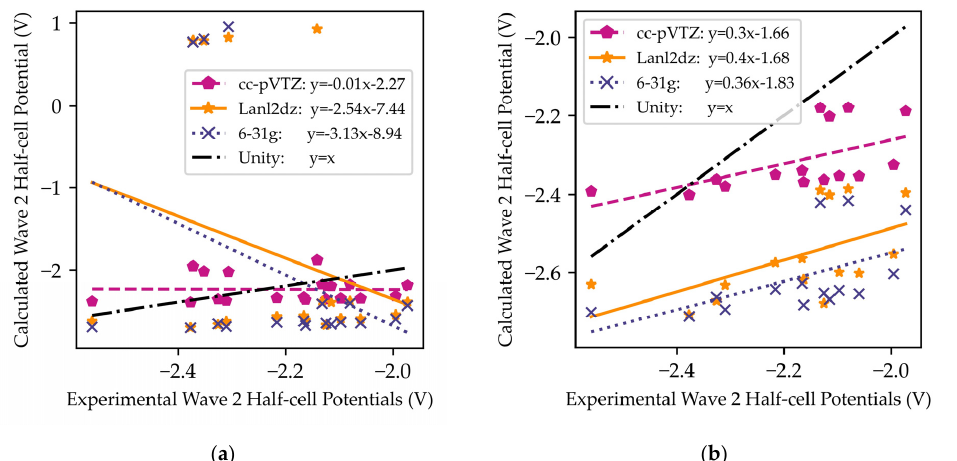
Figure 6. Comparison of computational electrochemical cell potentials vs. experimental [31] electro- chemical cell potentials for ( a ) wave 2 and ( b ) wave 2 with the nitro group containing derivatives (E1-E4) removed from analysis. The B3LYP/cc-pVTZ method is indicated by pink pentagons and the previously calculated methods B3LYP/lanl2dz and B3LYP/6-31G [27] are indicated with blue crosses and yellow stars, respectively. Derivative C3 is excluded from analysis.